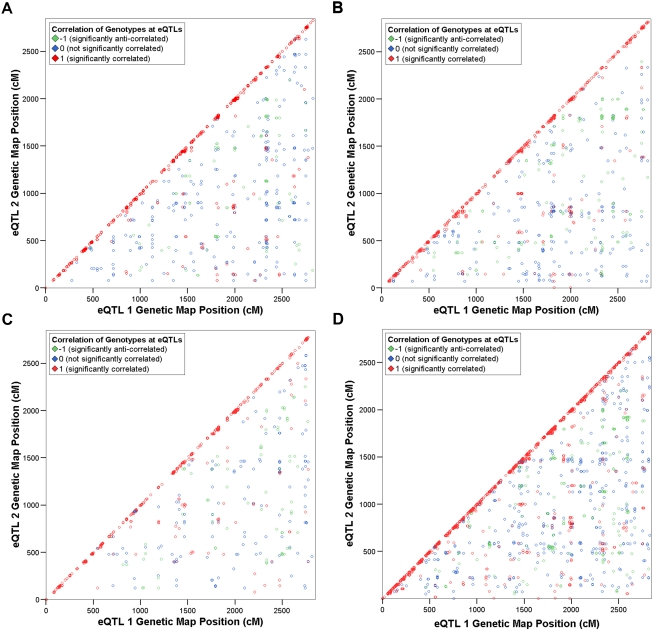
Scatter plots showing pairs of cis-eQTL genes with significantly correlated expression profiles by genetic map location.Significantly correlated pairs of cis-eQTL genes identified in a) fat, b) kidney, c) adrenal and d) left ventricle are plotted according to genetic map location (cM), indicating significance or otherwise of correlation of strain distribution patterns (SDPs) at the peak of linkage. Colour coding indicates significance of correlation of SDPs (p<0.05; see Methods). Pairs consisting of probesets located close to one another, which correspondingly have nearby peaks of linkage, are disproportionately represented among significantly correlated pairs as indicated by the red diagonal.